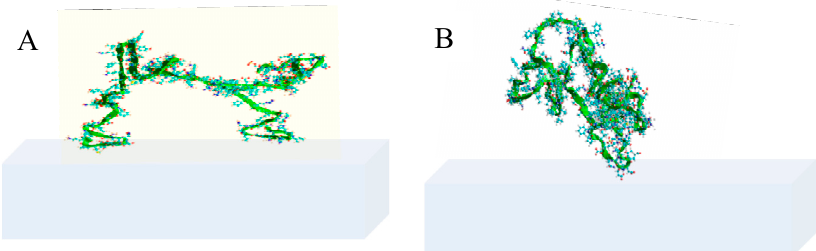
Figure 1. Schematic diagrams depicting typical conformations of ( A ) α -casein and ( B ) β -casein adsorbed onto a planar hydrophobic interface [18].